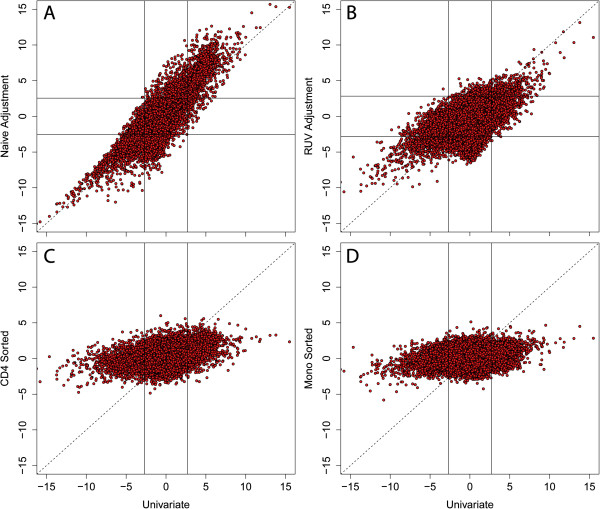
Confounding between cellular composition and age at the CpG level. Comparisons between resulting t-statistics for age on DNA methylation levels in Hannum et al. [10] using (A) naïve (for example, including cell composition estimates as covariates in regression models), (B) two-step Remove Unwanted Variation (RUV), (C) flow-sorted CD4+ T cells and (D) flow-sorted monocytes compared to the effect of age on DNAm in a univariate model. The univariate and naïve models also adjusted for processing plate, which was a very strong confounder. Here, analysis with RUV attenuates the association between DNAm and age. The solid lines indicate the resulting t-statistic cutoff for false discovery rate <5% - no probes were significant at this threshold in the cell sorted data. All panels contain probes present on both the Illumina 450k and 27k (n = 24,692) to facilitate comparisons to age associations in the flow-sorted cellular populations.